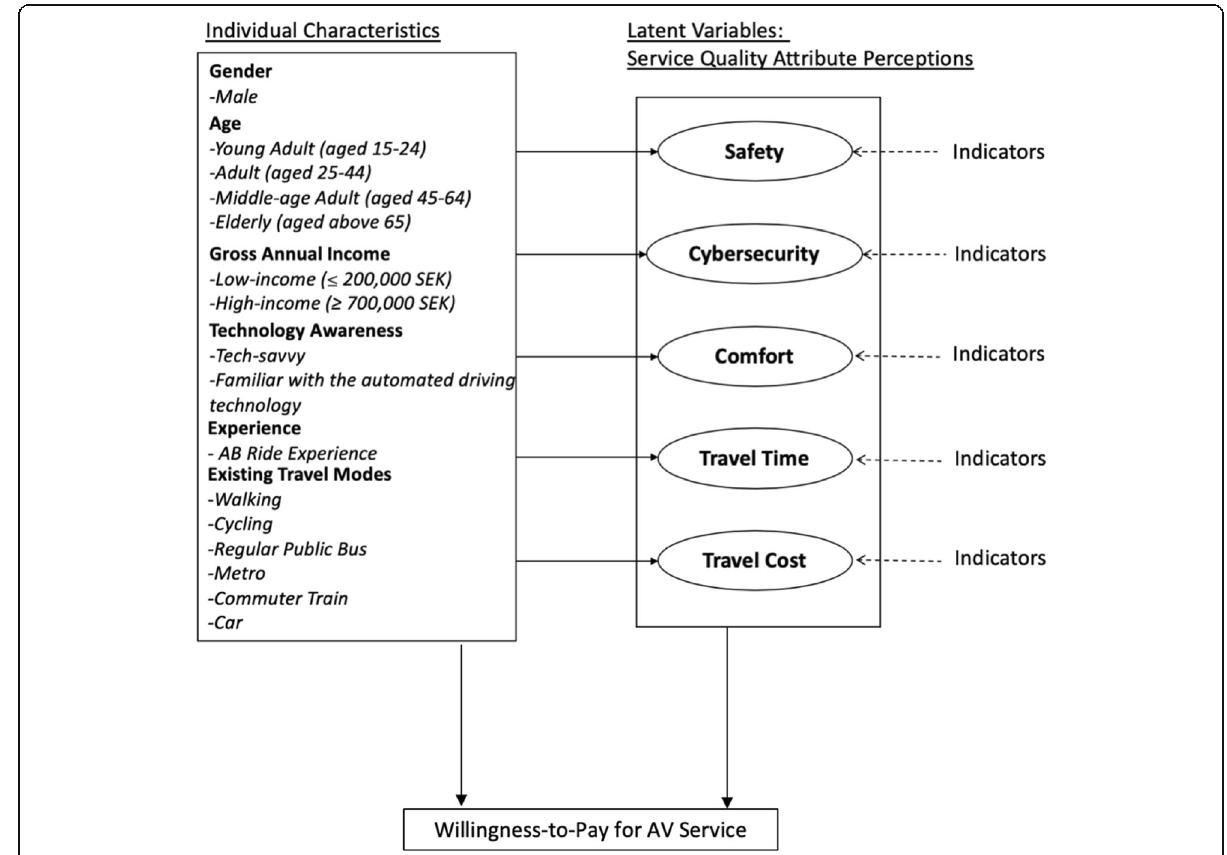
Fig. 1 Conceptual Model of WTP for AV